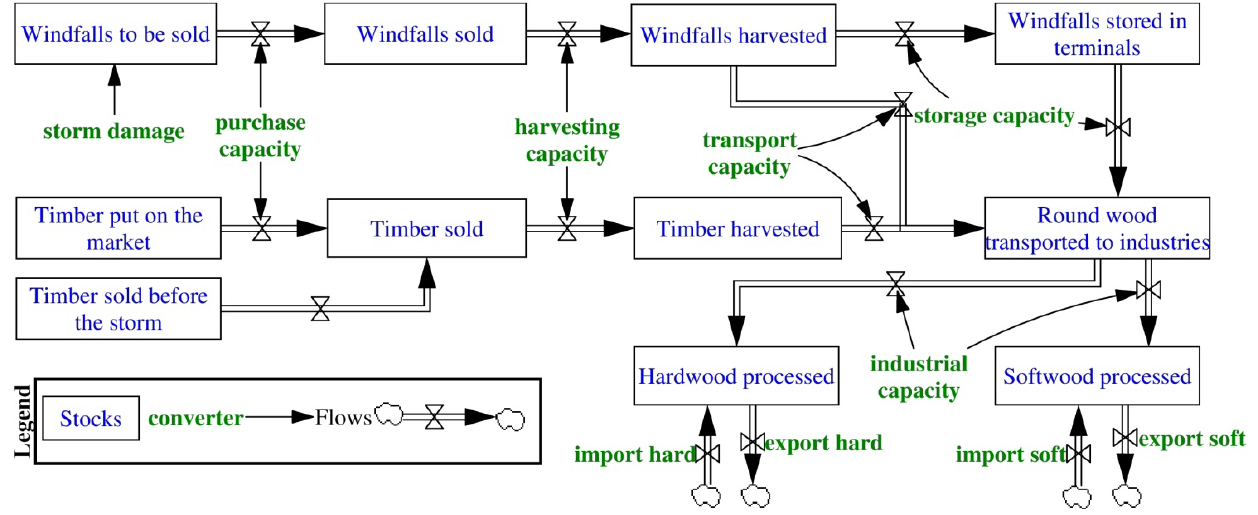
Figure 1. Conceptual representation of the regional forest-wood